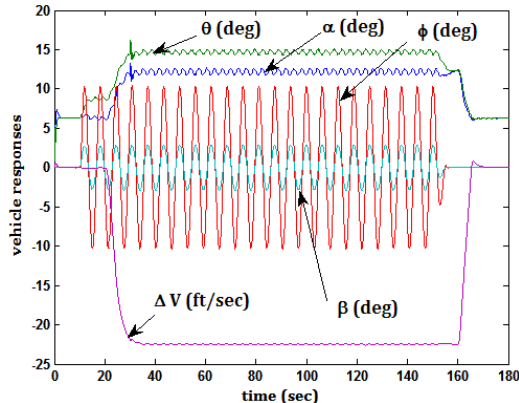
Figure 13. Vehicle responses for Task 3.